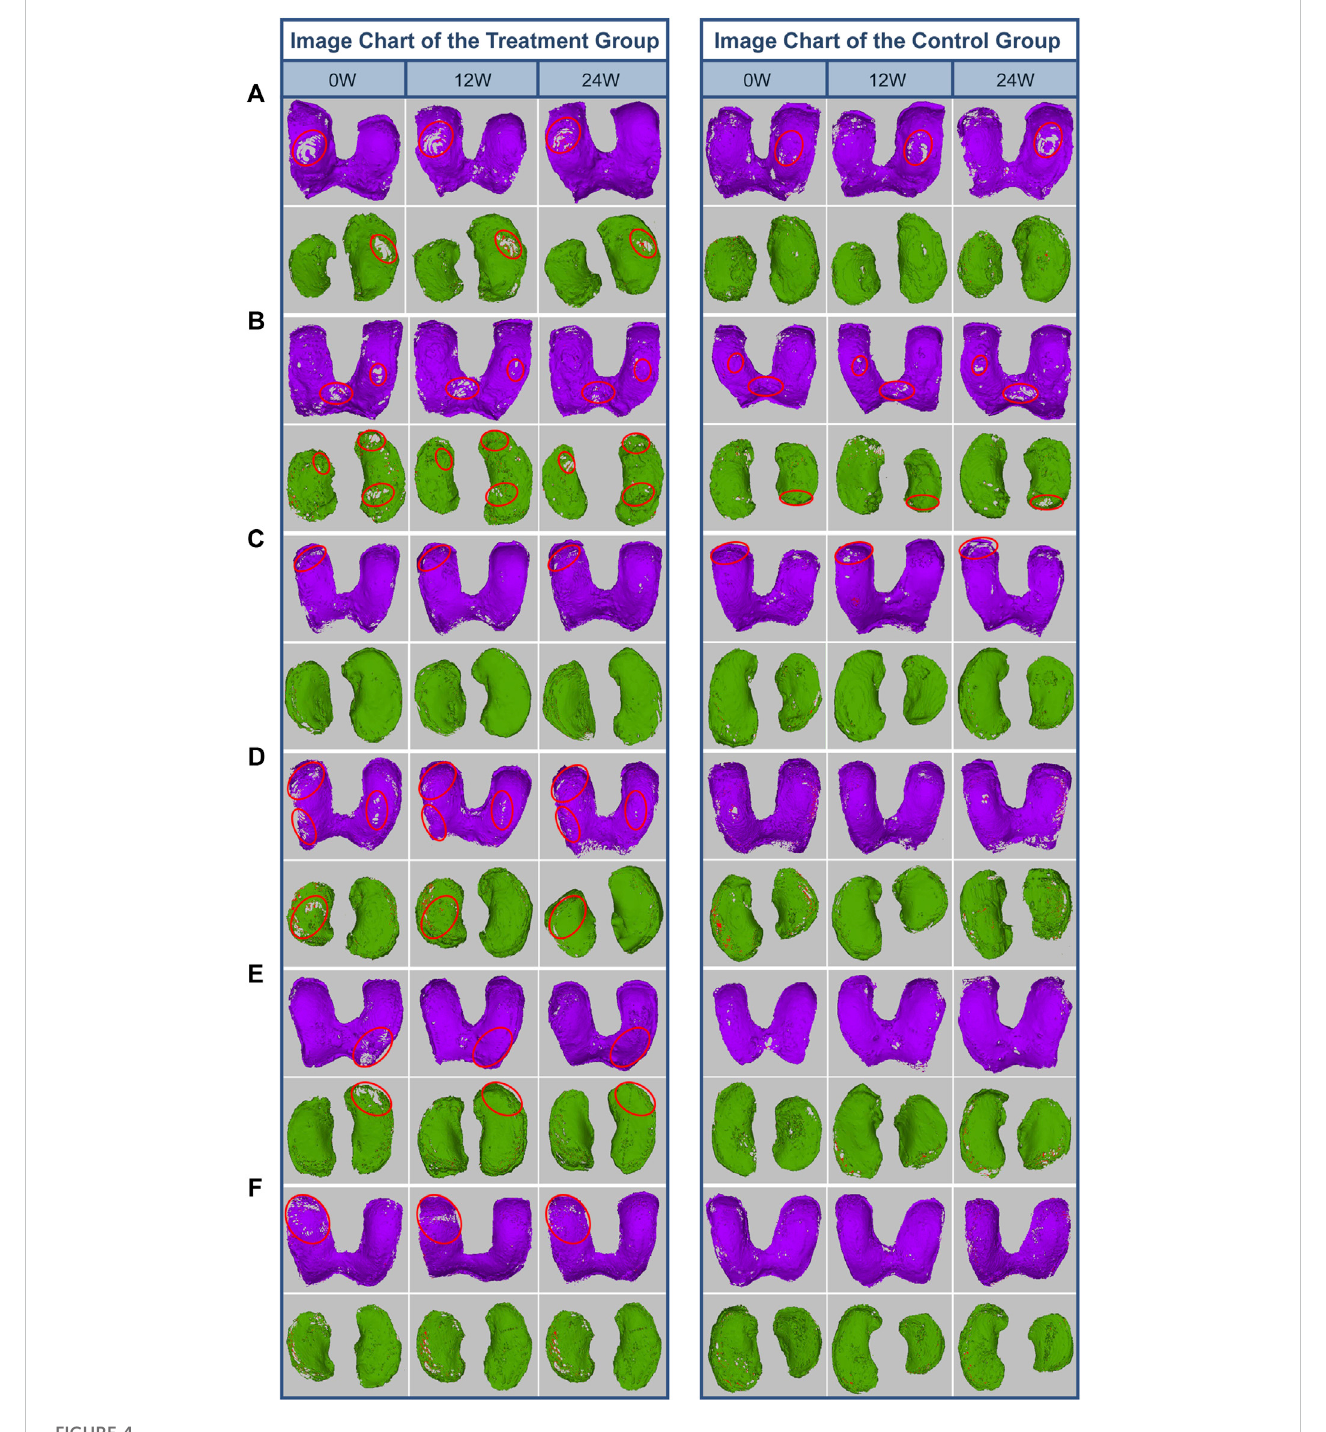
FIGURE 4 Qualitative analysis of femoral cartilageand tibial cartilage defects of 6 enrolled patients. (A) Patient1: female, 69 years, BMI = 23.5. (B) Patient 2: female, 69 years,BMI=20. (C) Patient3:female,64 years,BMI=23.8. (D) Patient4:female,59 years,BMI=29.2. (E) Patient5:female,59 years,BMI=27.3. (F) Patient 6:male,53 years, BMI=25.0.AfterasingleinjectionofSVFthefemurand/ortibiacartilagedefectsofall6patientsshow improvement,someshowsigni fi cant reduction at 12 and 24 weeks post therapy in comparison with pretreatment. In contrast, most the defects of untreated group show deterioration and some new defects are